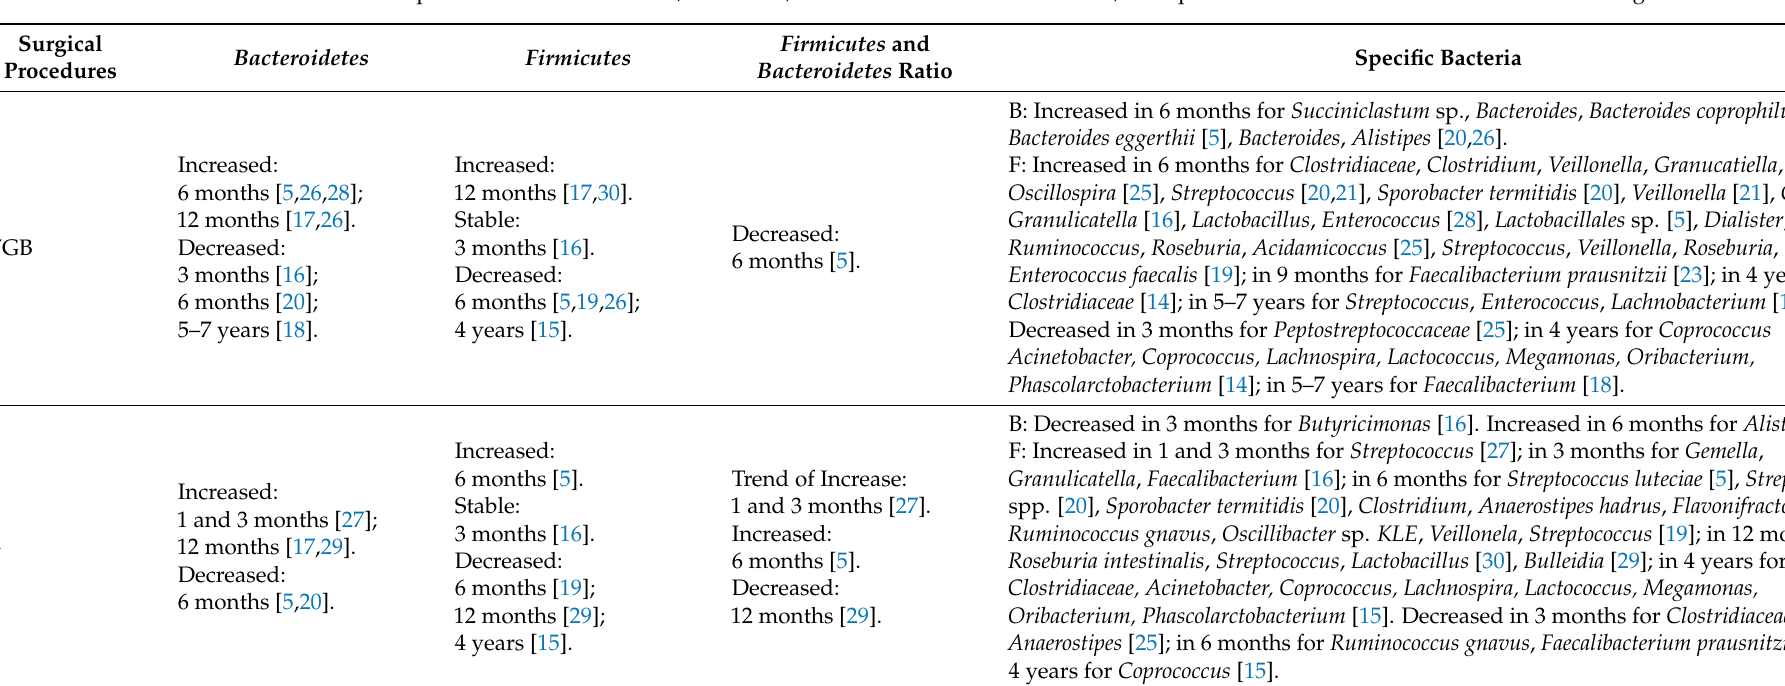
Table 3. Comparison of the Bacteroidetes , Firmicutes , Firmicutes and Bacteroidetes ratio, and specific bacteria between the RYGB and SG